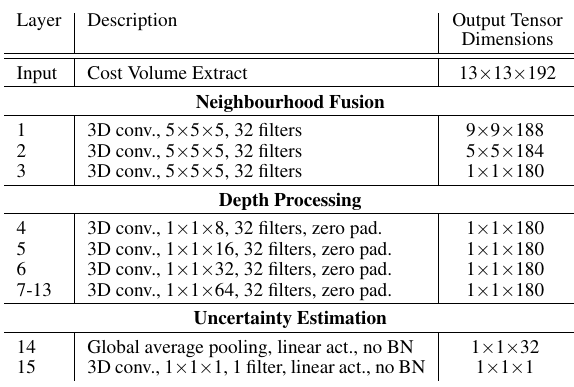
Table 1. Summary of the modified CVA-Net architecture. Un- less otherwise specified, each layer is followed by batch norm- alisation (BN) and a ReLU non-linearity. (Adapted from (Mehl- tretter and Heipke, 2021).)